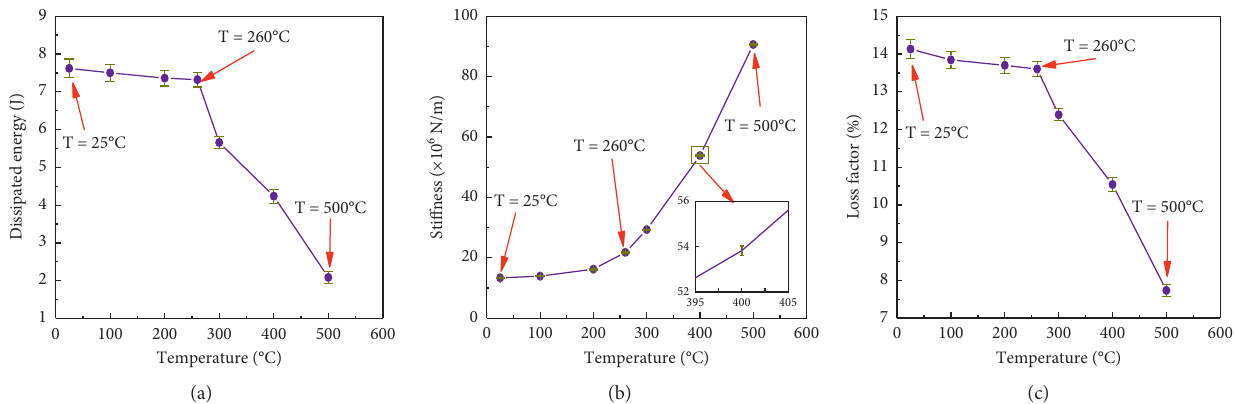
Figure 12: Dissipated energy, secant stiffness, and loss factor of EMWM under different ambient temperature. (a) Dissipated energy in one cycle ( Δ W), (b) secant stiffness ( k ), and (c) loss factor ( η